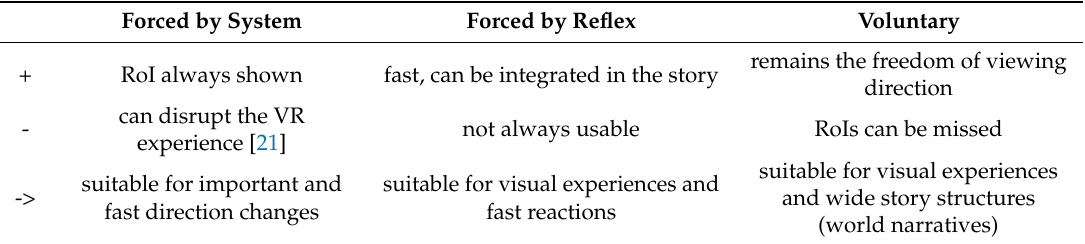
Table 9. Advantages and disadvantages of voluntary and forced methods. The third row indicates for which requirements the methods are suitable.